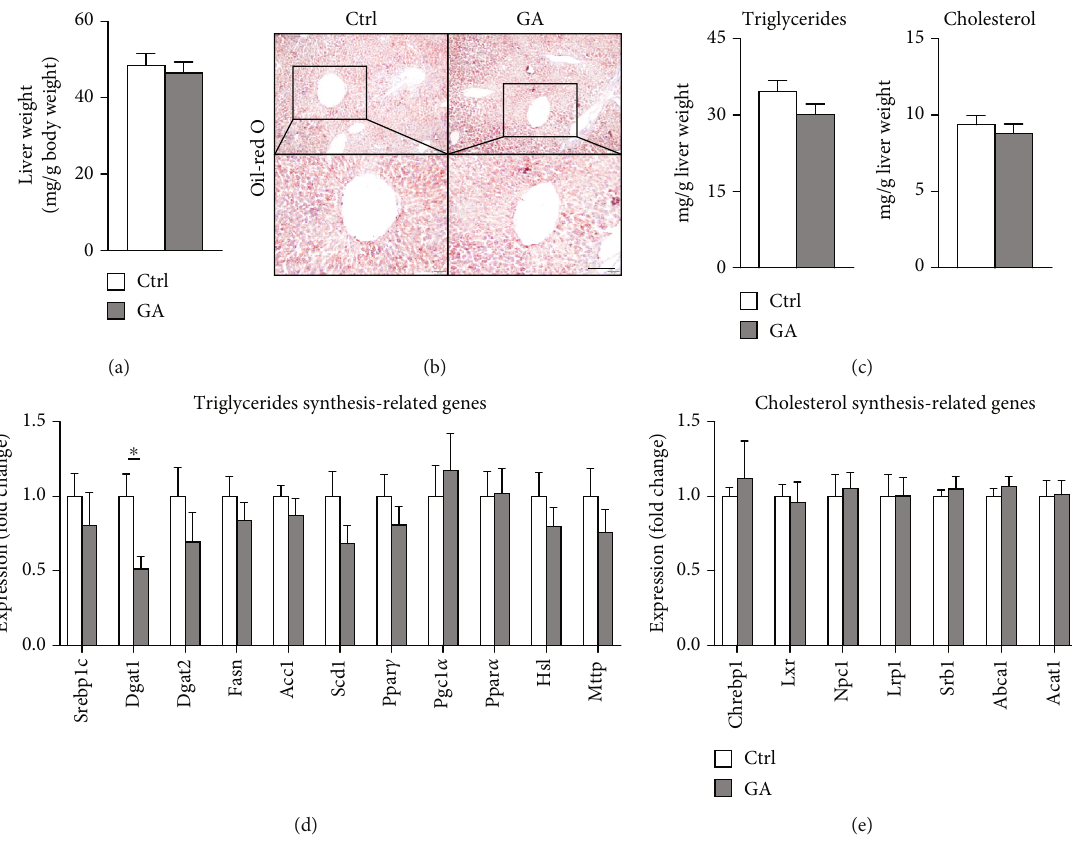
Figure 2: E ff ect of low-dose GA administration on diet-induced hepatosteatosis in the Apoe KO mice. (a) Liver weight. (b) Representative Oil-red O staining images of liver section. The bar represents 100 μ m. (c) Quantitation of hepatic triglyceride and total cholesterol content. (d, e) Quantitative real-time PCR analysis of triglycerides synthesis-related (d) and cholesterol synthesis-related (e) gene expression in the liver. n = 6 -8 per group. ∗ p < 0 : 05